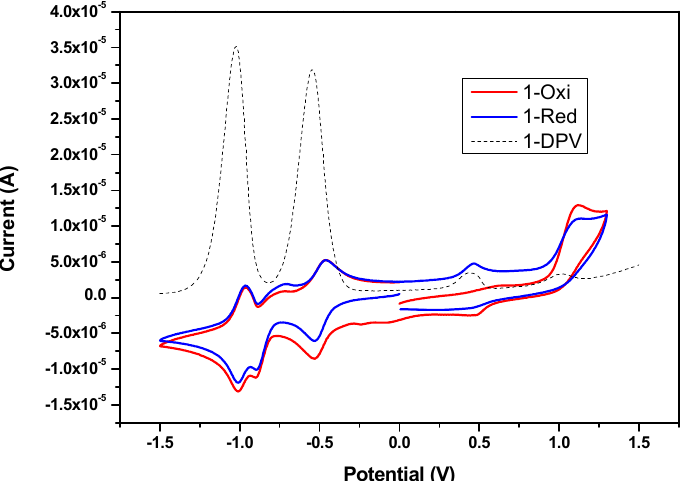
Figure 8. Di ff erential pulse voltammetry (DPV) in the black dashed line and a cyclic voltammogram (CV) of 1 were measured in DMF with 0.1 M TBAPF 6 . The CV of 1-Oxi in the red solid line indicates that oxidation was run first and the 1-Red in the blue solid line indicates that reduction was run first. Pt wire, Pt disk, and Ag / AgCl were used for measurements with a scan rate of 0.1 Vs − 1 .